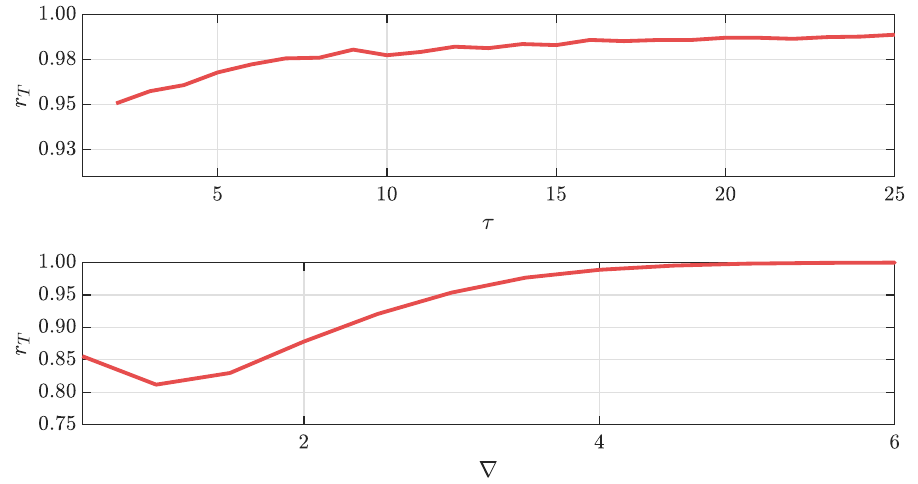
Figure 6. Ratio r T of the success probabilities between the VI and the MS approach using n = 10 repeated observations. The top figure depicts r T for the case of inflated variances. The bottom figure depicts r T for the case of shifted mean